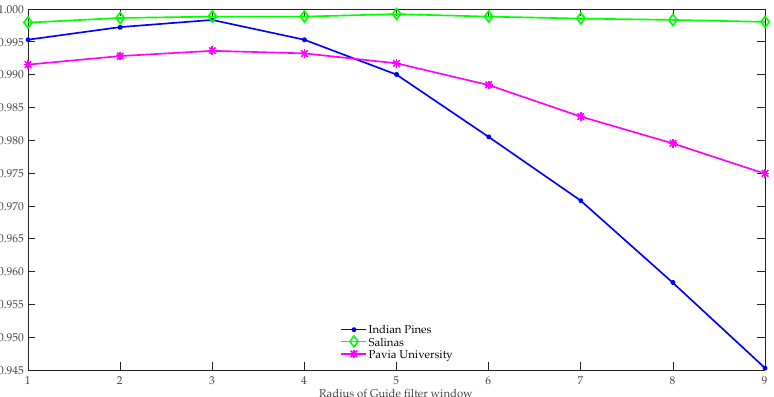
Figure 8. The relationship of OA and r in the three datasets.